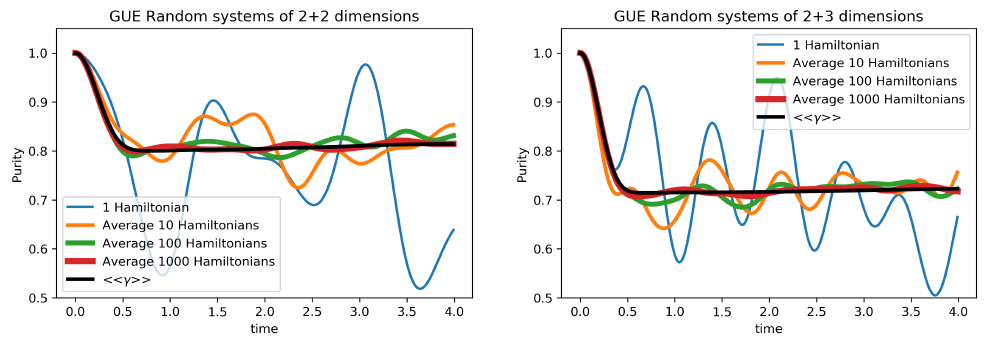
Figure 10: 〈〈 γ ( t ) 〉〉 of a qutrit, coupled ∈ [ 1,...,5 ] . d = 5 in- to baths of d B B volves polynomials of degree up to 98 in t , admitting numerical error.